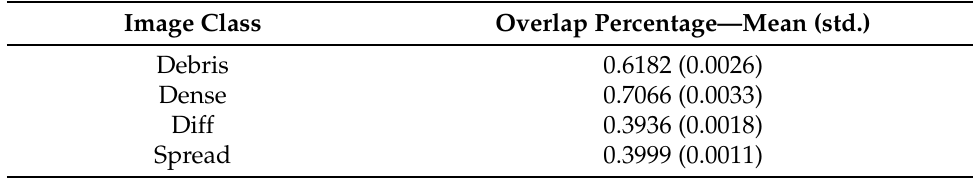
Table 4. Overlap percentage for image entropy histograms across five trials, for which the entropy val- ues of 50,000 random real and generated image patches each are plotted and the overlap is calculated. Variation in values is caused by randomly generated image patches that contain variability within the image. These values can be used to determine how well the generator has been able to model image features and can be correlated with the performance of downstream dataset augmentation